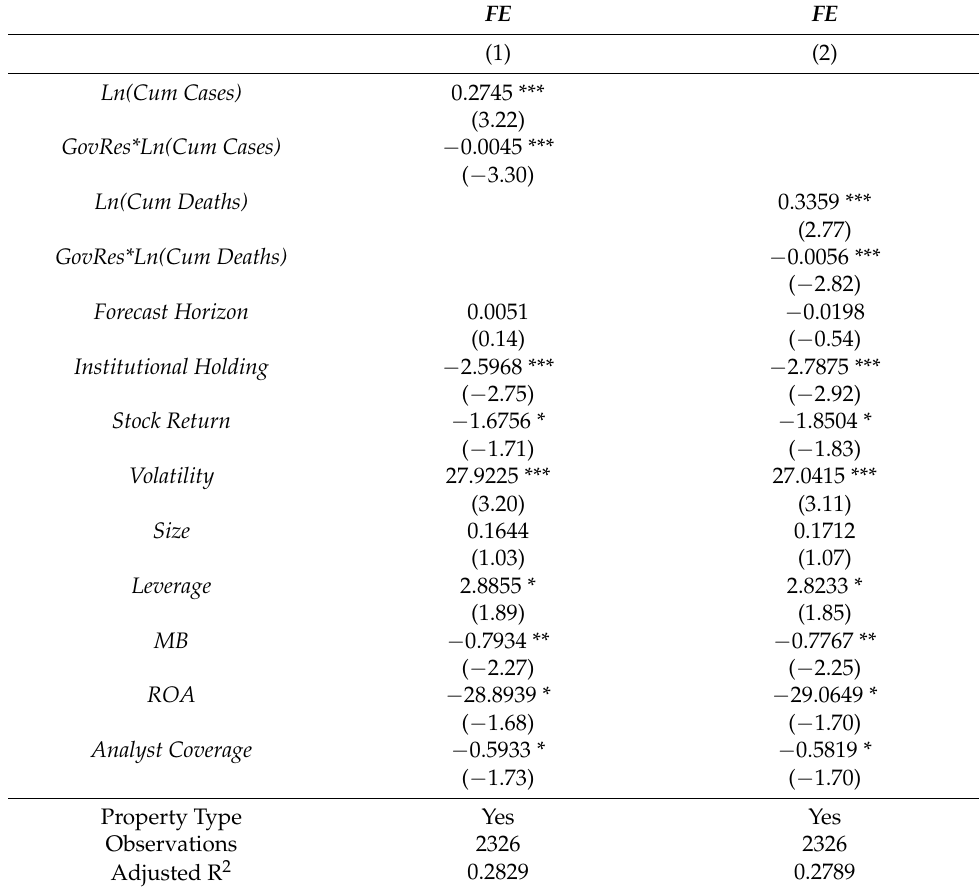
Table 3. The COVID-19 Pandemic and Forecast